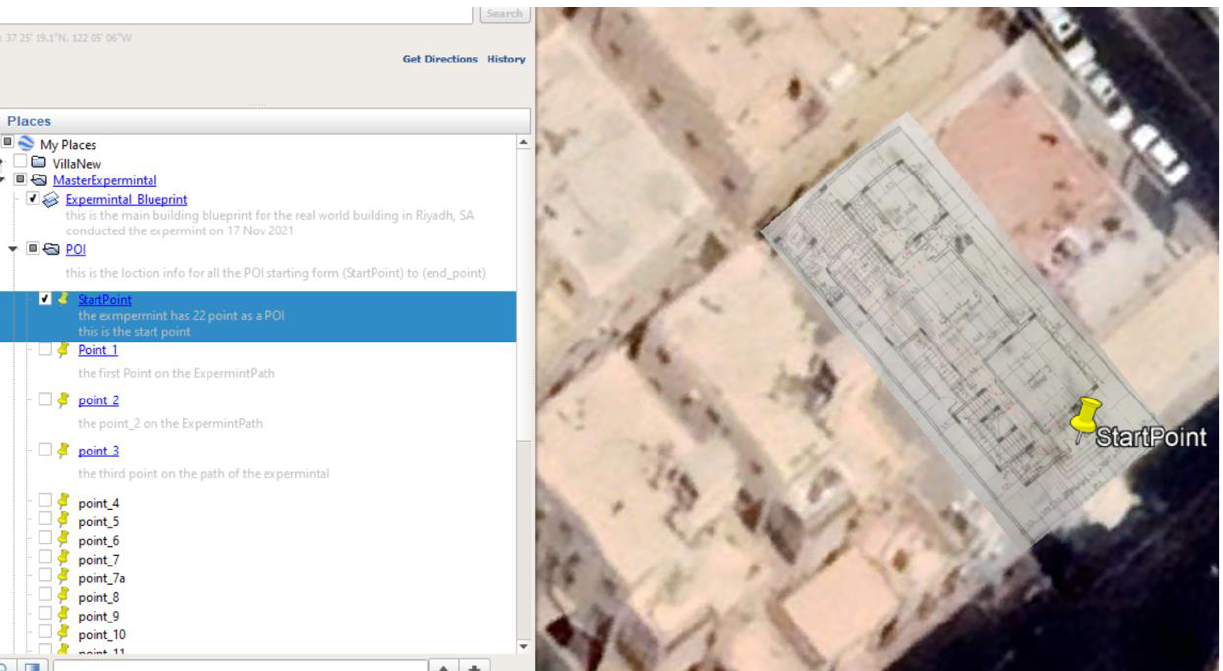
Figure 26. Labeled POIs on the blueprint map.